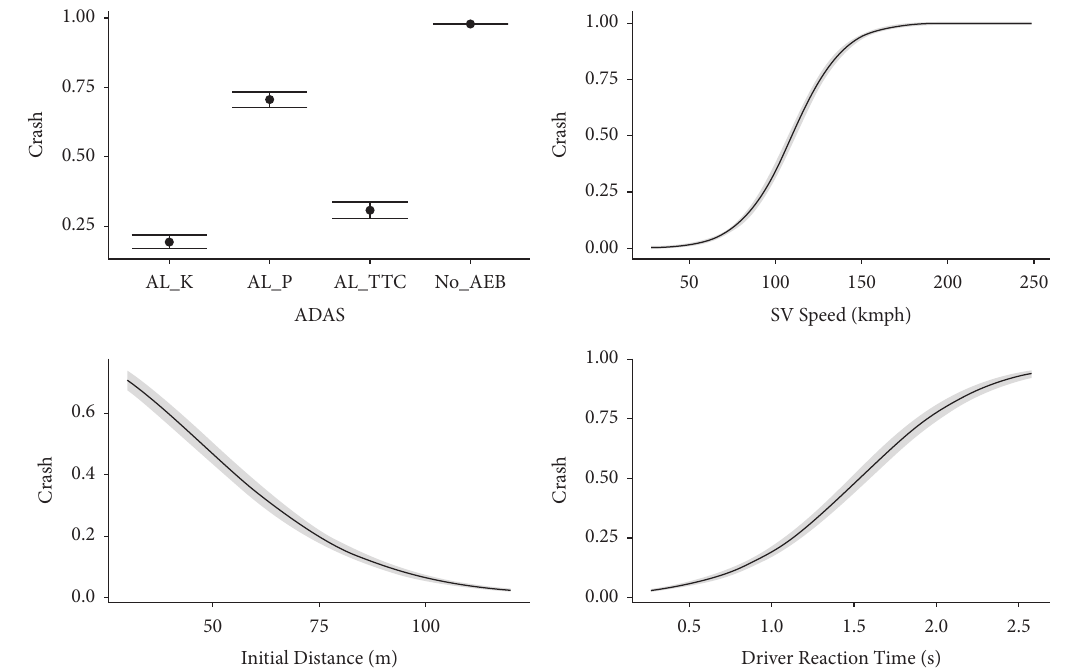
Figure 11: Effect plots for four important parameters resulted in the crash model (confidence interval of 95%).